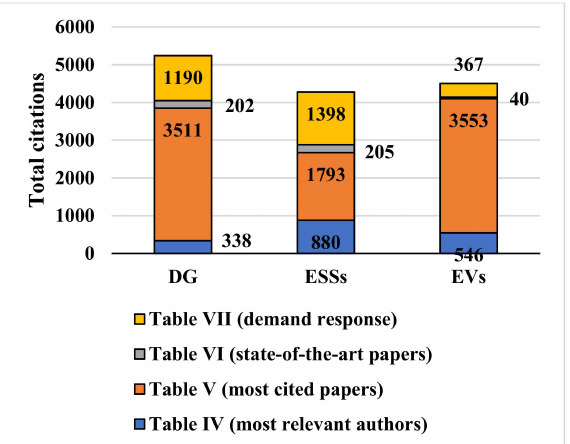
Figure 10. Comparison among the emphasis on distributed generation, energy storage systems, and electric vehicles in terms of total citations. Source: own study using data from Bibliometrix.